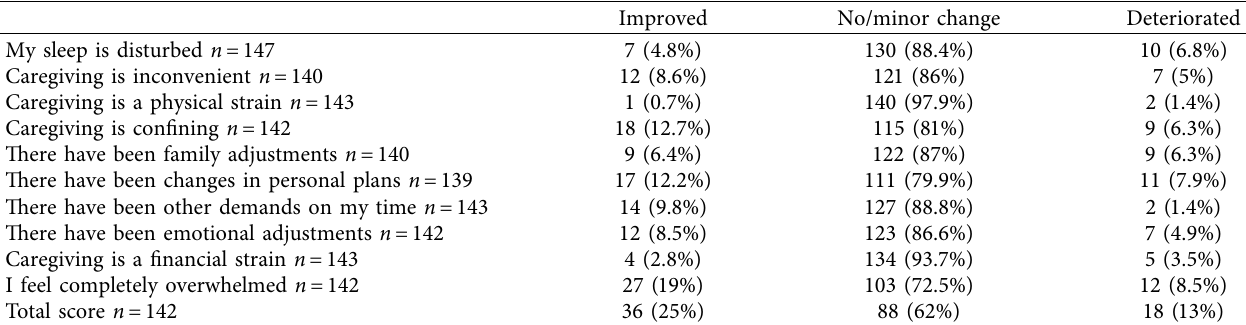
Table 3: Caregivers divided into groups, based on level of perceived strain, and comparisons of change in Caregiver Strain Index domains between 3 and 18 months, in frequencies ( n ) and percentages